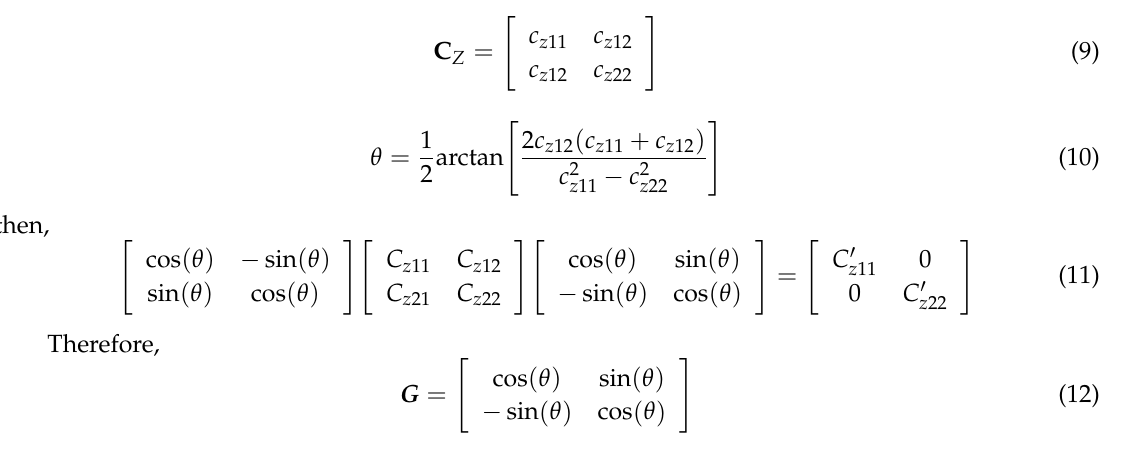
Figure 2. Lamb waves incident angle dispersion curve. The multimodal Lamb wave signals at the propagation distance of 1.6 cm and 2.7 cm are recorded and shown in Figure 3. Figure 3. Multimodal Lamb wave signals at the propagation distance of ( a ) 1.6 cm and ( b ) 2.7 cm. 0